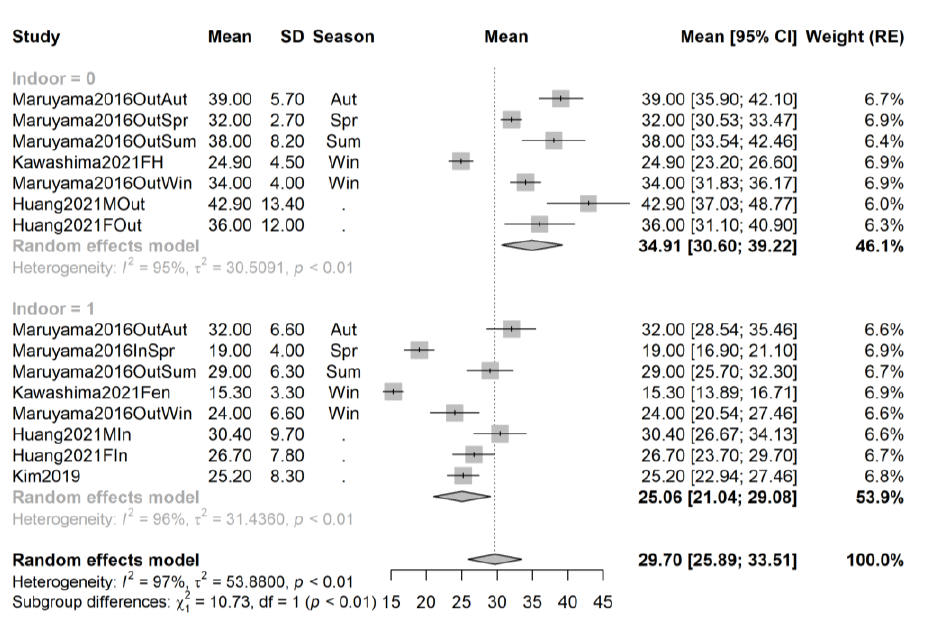
Figure 3. Forest plot of all studies performed on Asian athletes sorted by season. Studies [45,47,48,67].